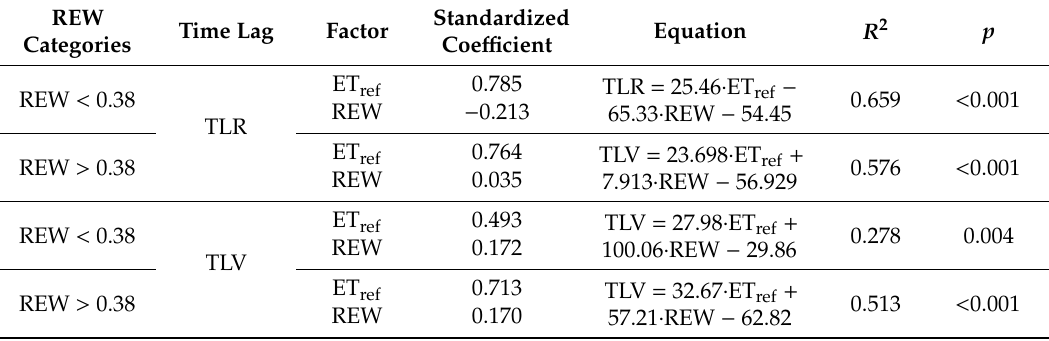
Table 2. Regressions between time lag (TLR refers to the time lag between solar radiation and sap flux density; TLV refers to the time lag between vapor pressure deficit and sap flux density) and ET ref (reference crop evapotranspiration) and REW (relative extractable water) in di ff erent REW categories: REW < 0.38 and REW > 0.38. R 2 refers to the determination coe ffi